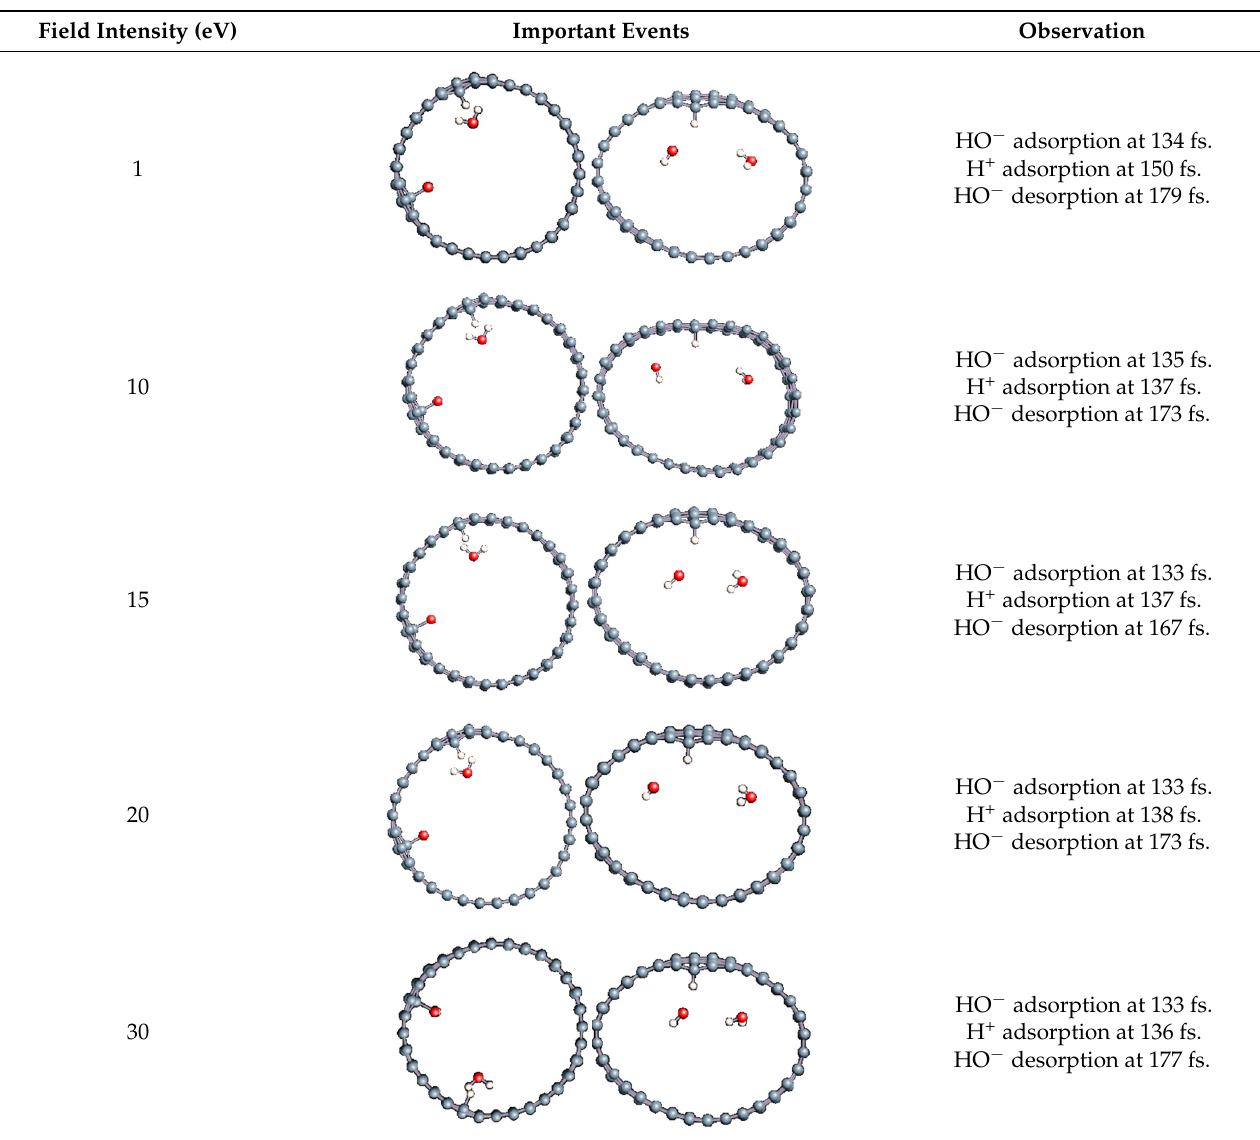
Table 5. Dissociated and undissociated water molecules inside (16,0) CNT under electric